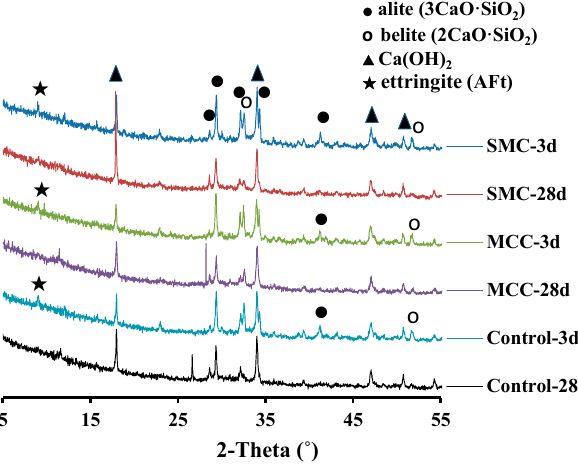
Figure 6. XRD patterns of cement pastes after 3 and 28 days of hydration.